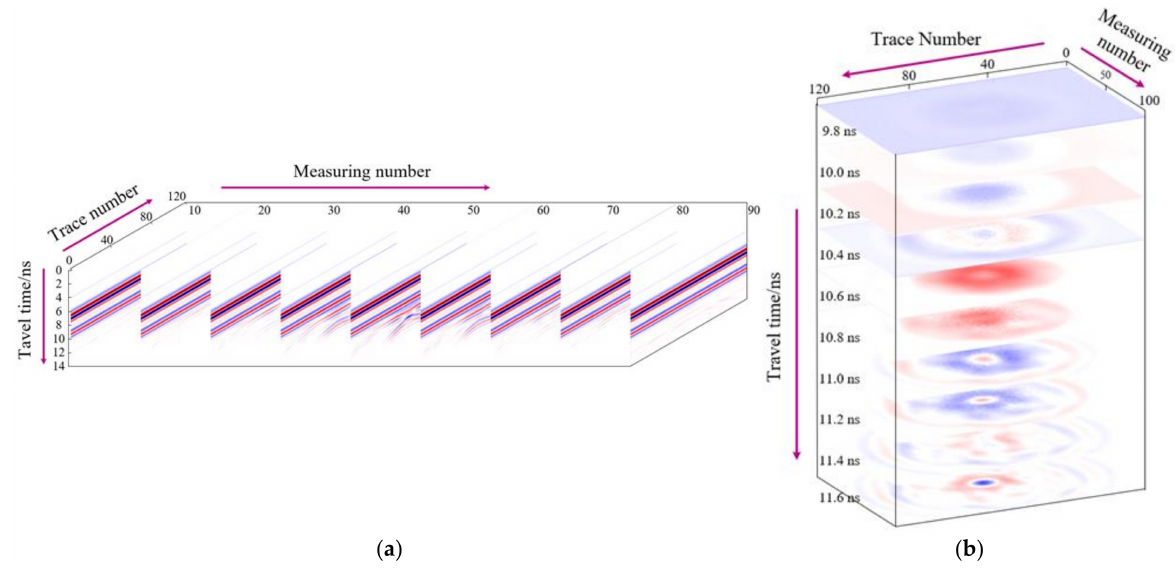
Figure 3. Sacked morphological images extracted from an irregular cavity: ( a ) stacked B-scan images; ( b ) stacked C-scan